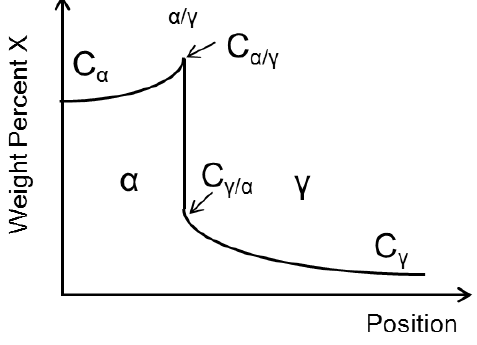
Figure 3. Schematic diagram of the C concentration profile output of DICTRA.